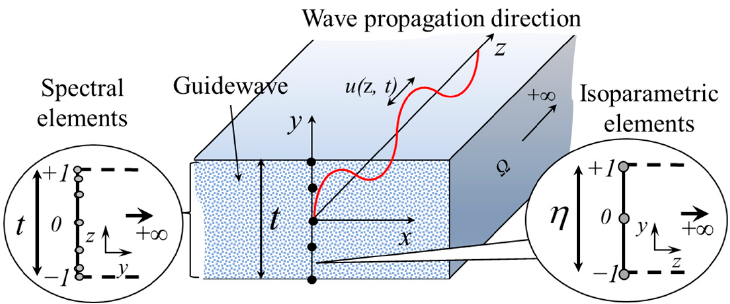
Figure 1. Schematic representation of the plate and SBFEM model.